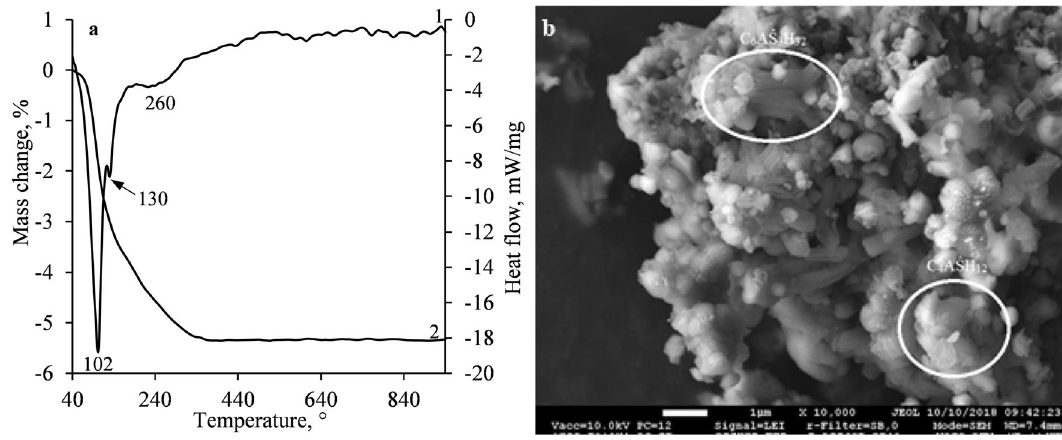
Figure 7. STA ( a ) curves (1-DSC; 2-TGA) and SEM micrographs ( b ) of S1-1100 sample after 12 min of